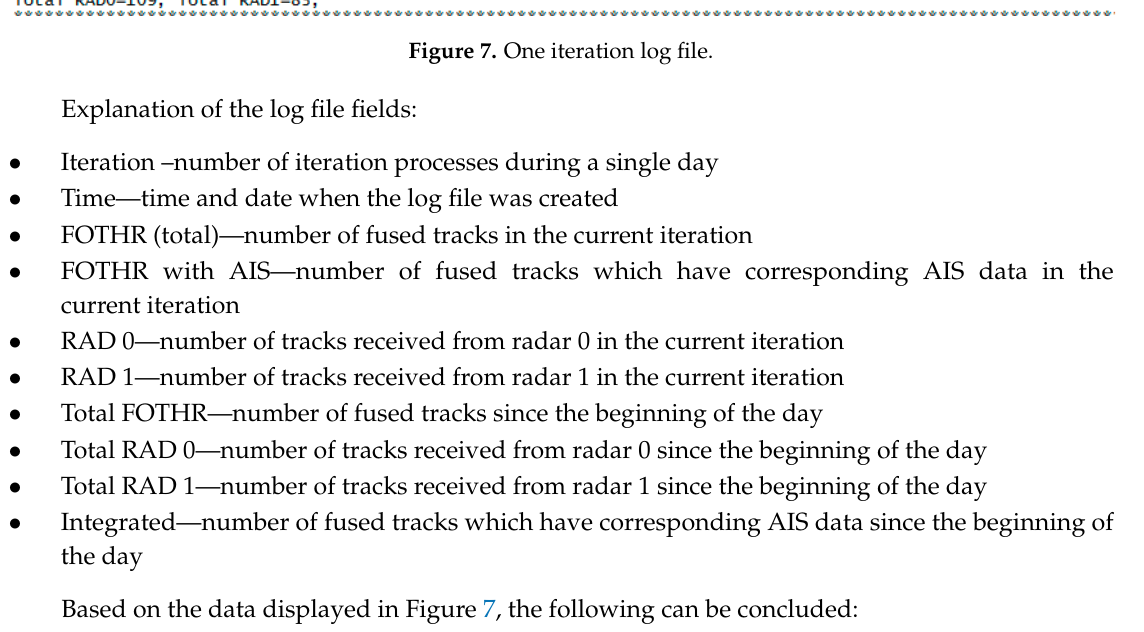
Figure 7. One iteration log file.